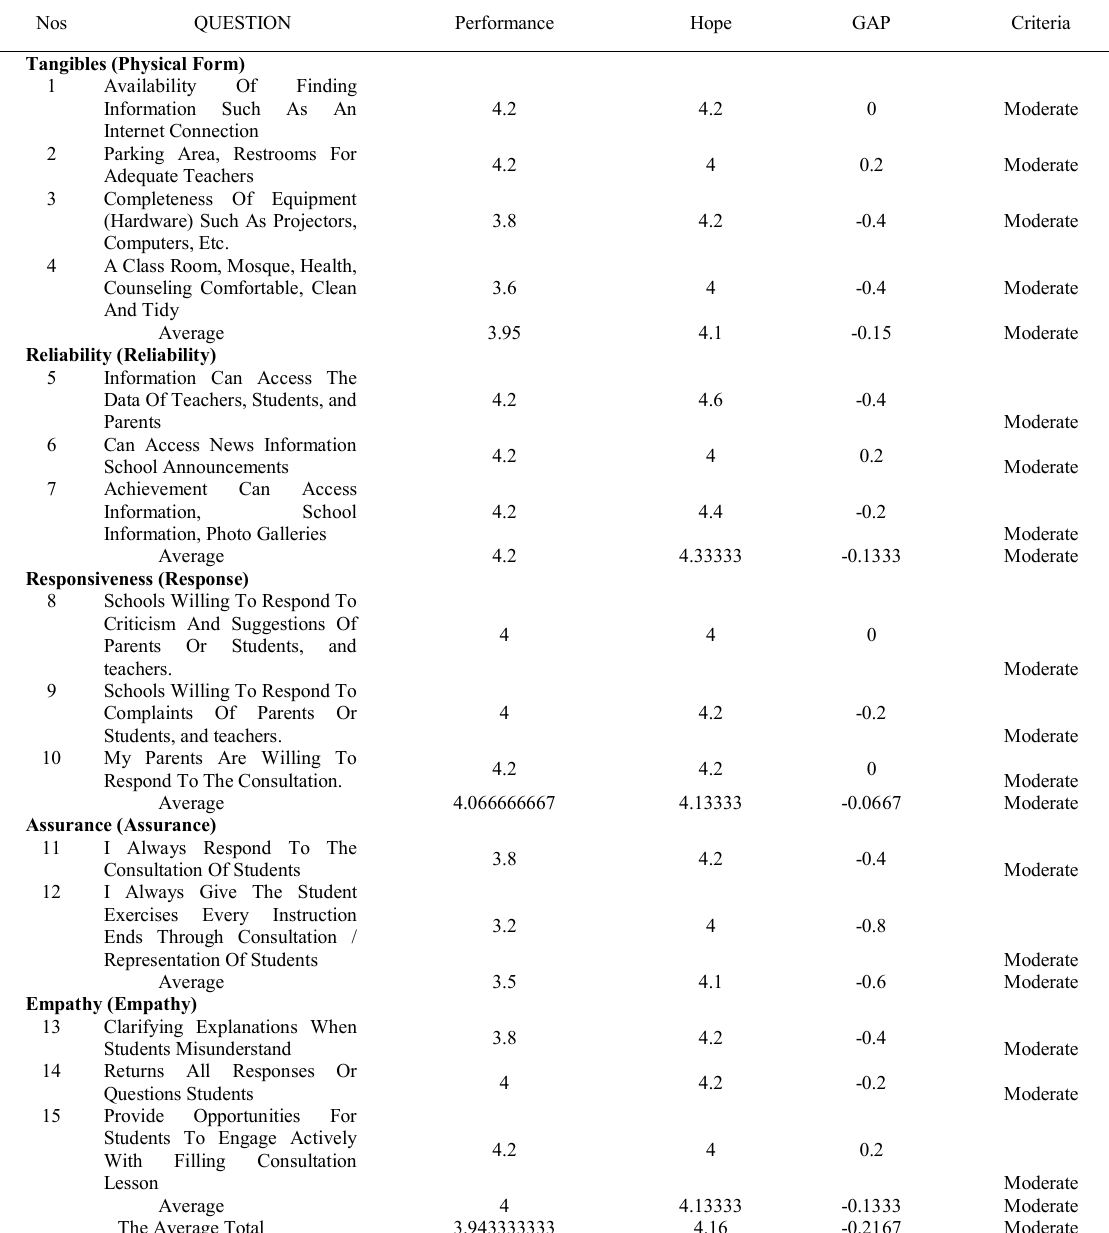
TABLE 5. VALUES SERVICE QUALITY